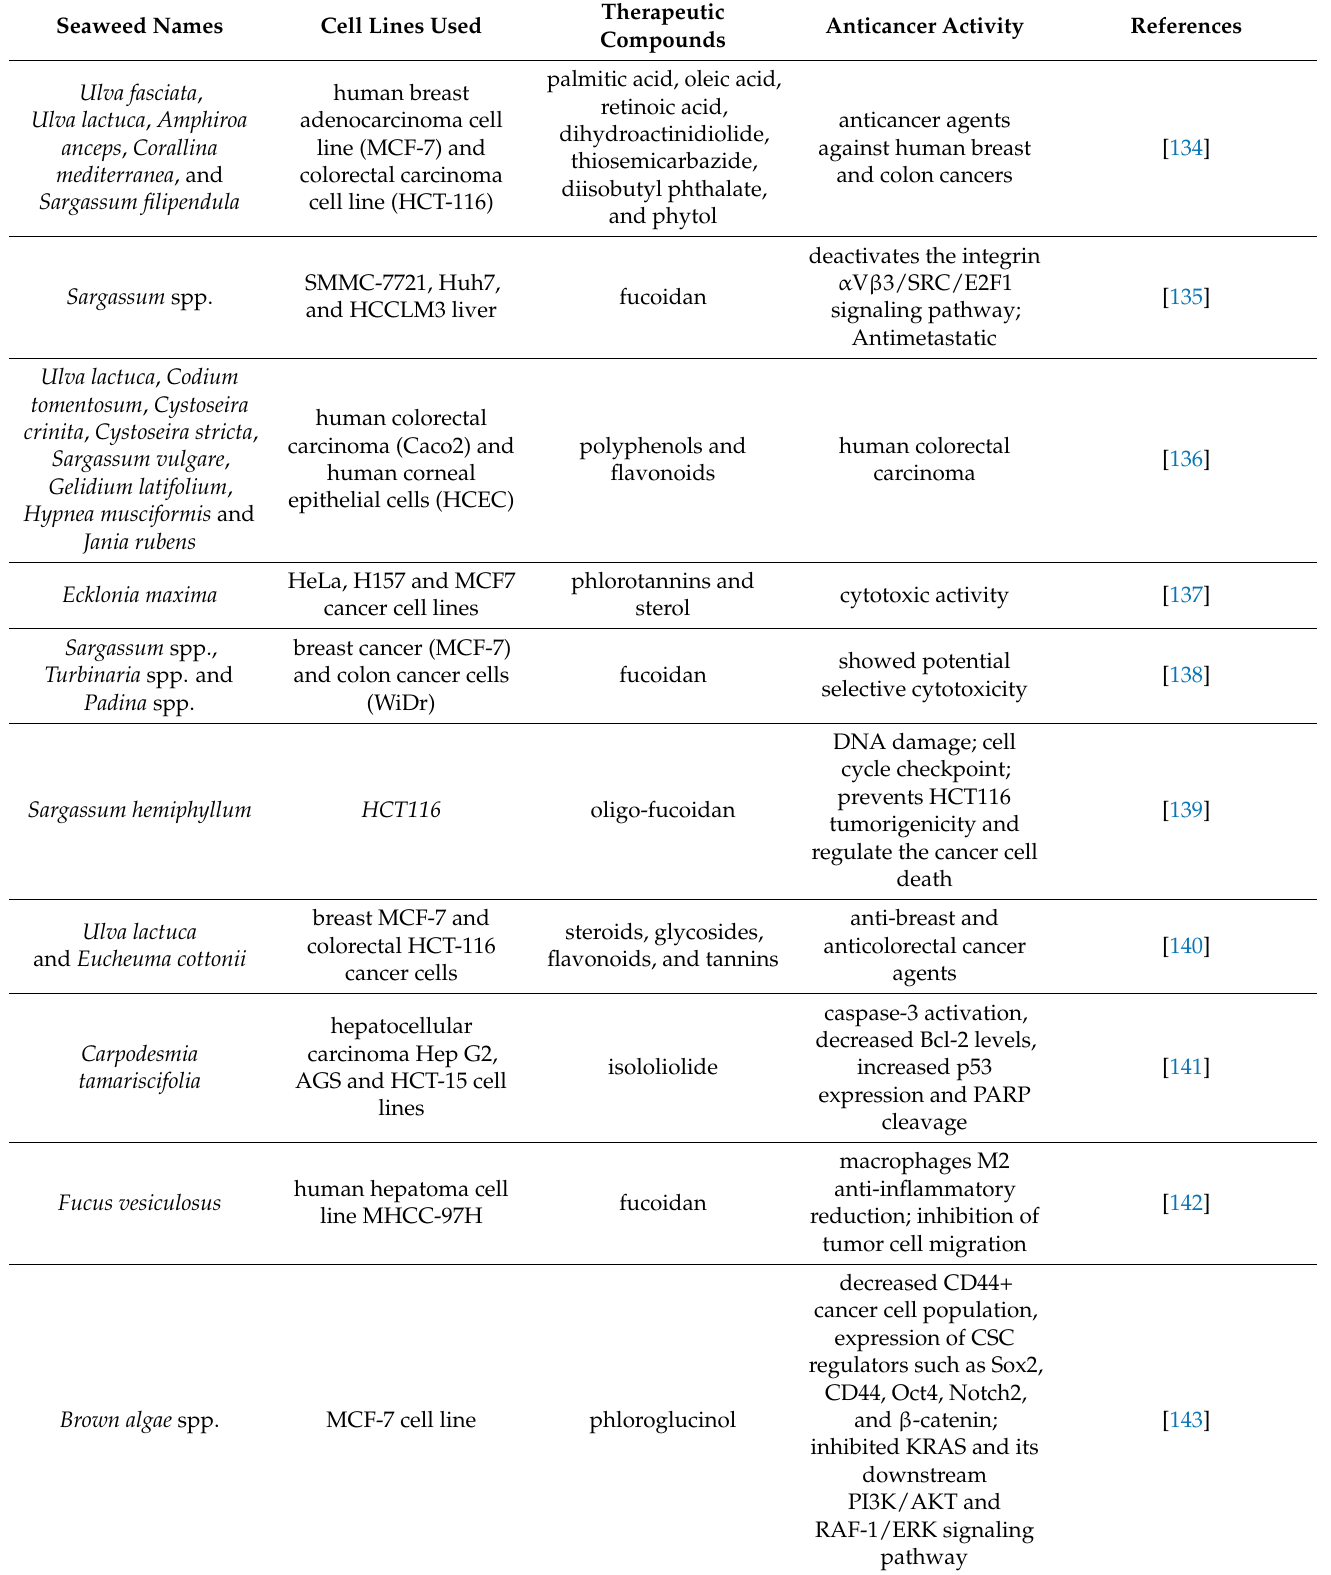
Table 2. Cytotoxicity of seaweed-derived compounds toward anticancer